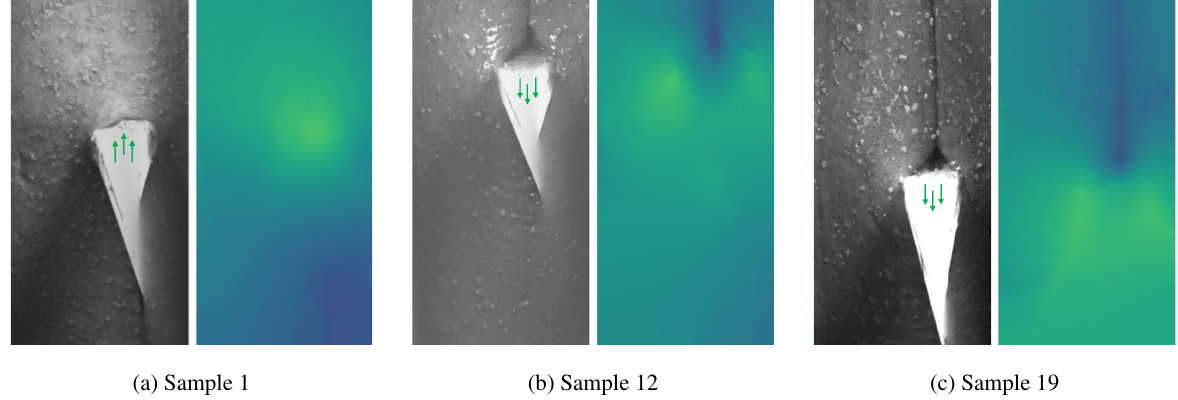
Figure 3. Examples of the input data: Generated orthophoto and depth map of different samples. The green arrows show the moving direction of the paddle. If the direction of movement is towards the camera (a), the DEM primarily shows a pile of gel that the mixing paddle creates in front of it. If the direction of movement of the paddle is away from the camera (b and c), the reconstruction mainly shows the groove that the paddle pulls through the gel. In the DEM, green corresponds to a higher and blue to a lower elevation.